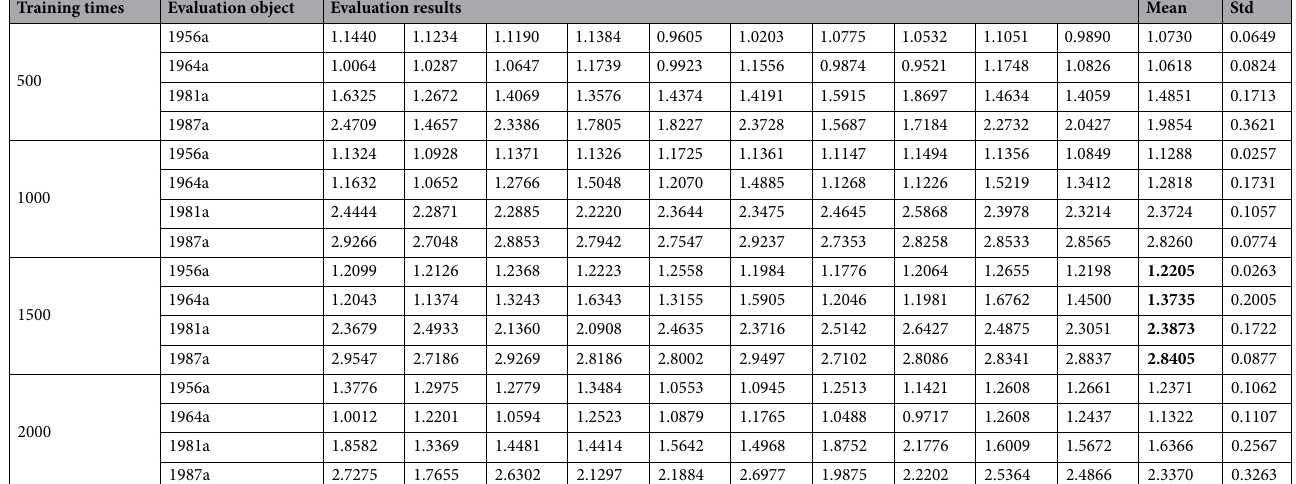
Table 6. The evaluation results of T–S FNN under different training times under the assumption that each evaluation index is normally distributed. Significant values are in